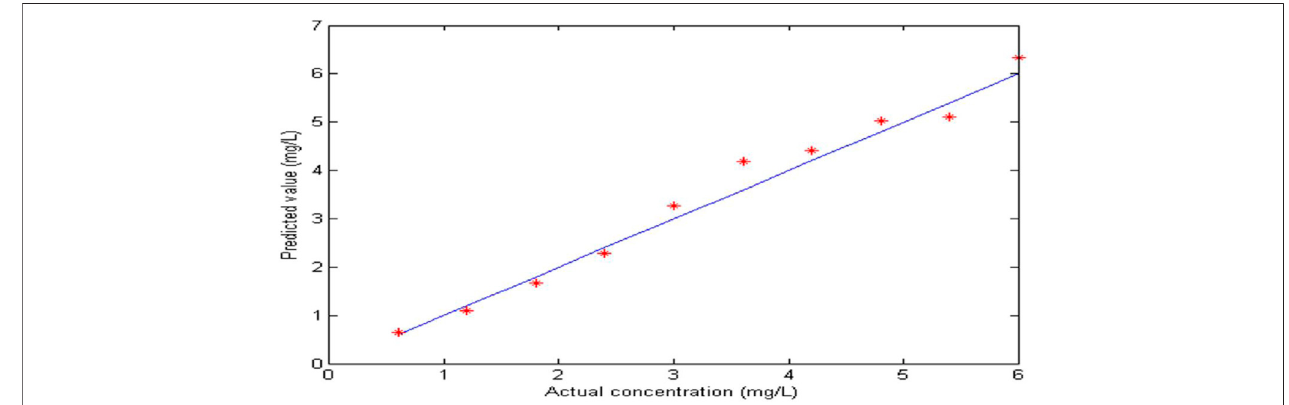
FIGURE 6 | Predicted and actual concentration values of nickel in mixture solution.